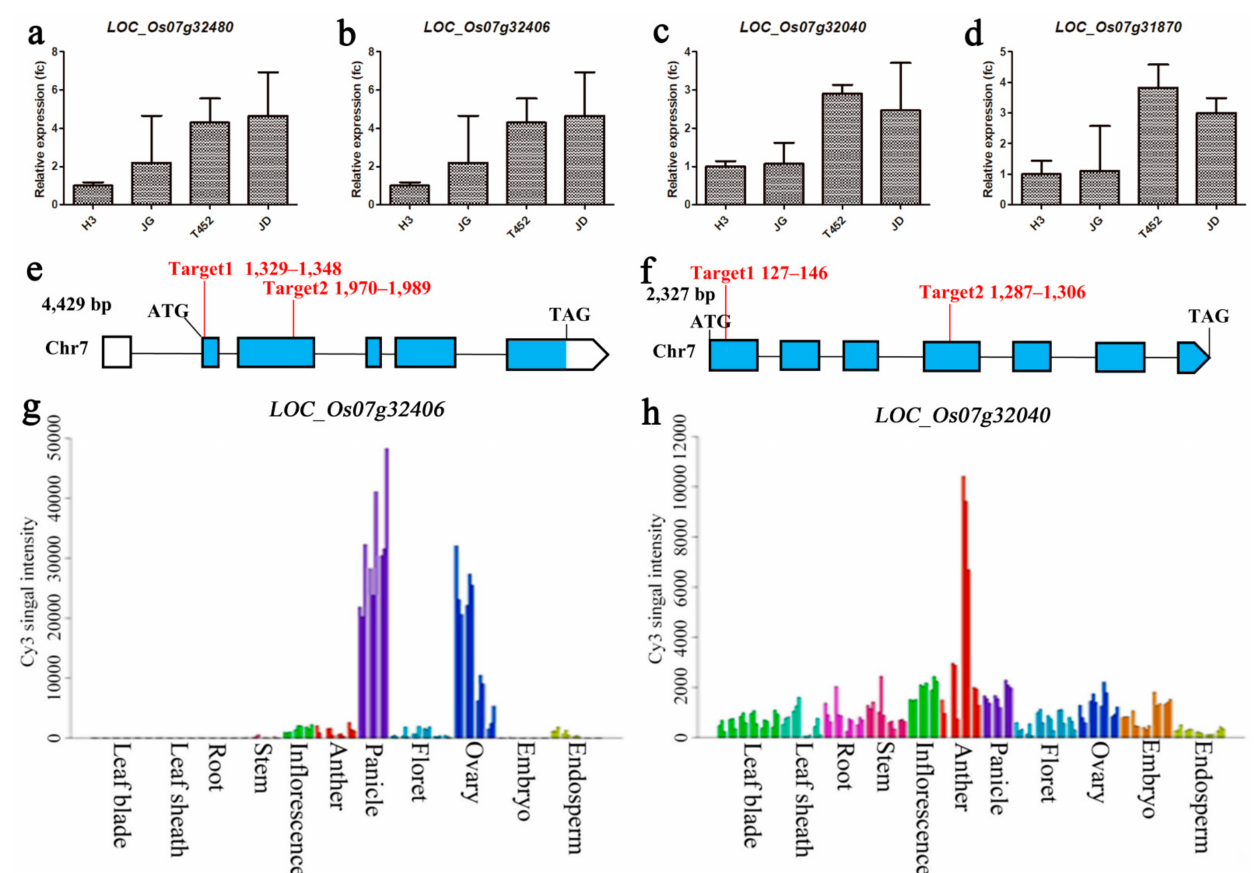
Figure 4. Expression analysis of 4 candidate genes in high fertility blocks. QRT-PCR results of LOC_Os07g32480 ( a ), LOC_Os07g32406 ( b ), LOC_Os07g32040 ( c ), and LOC_Os07g31870 ( d ). The ubiquitin gene was used as an internal control. Fc, fold change. The error bars ( a – d ) indicate SE. The gene structure and target site for CRISPR/Cas9 of LOC_Os07g32406 ( NY1 ) ( e ) and LOC_Os07g32040 ( NY2 ) ( f ). The predicted expression patterns of LOC_Os07g32406 ( NY1 ) ( g ) and LOC_Os07g32040 ( NY2 ) ( h